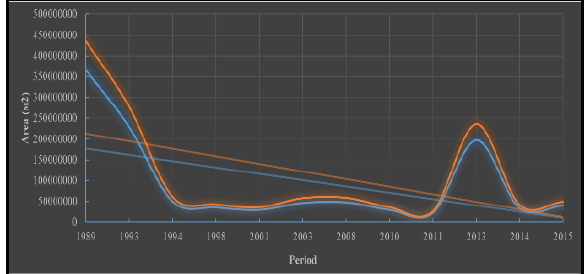
Figure 4. The potential 2D and 3D surface area of study site